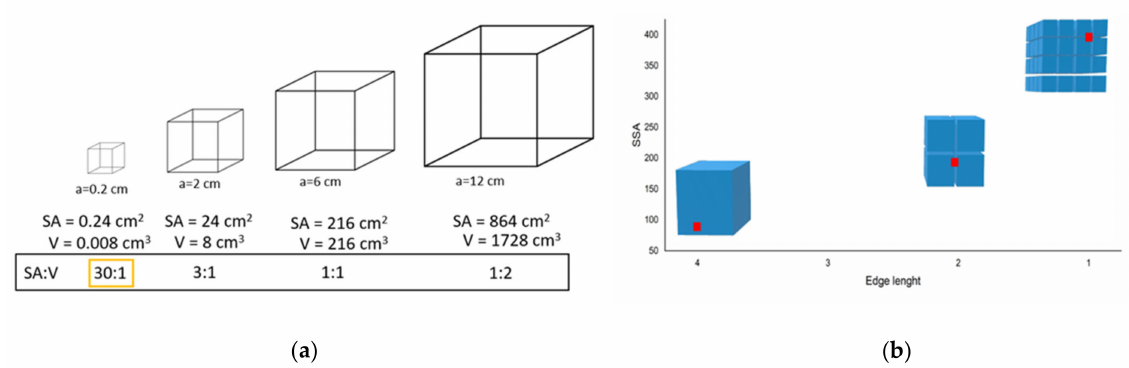
Figure 2. ( a ) Size dependence of the surface-to-volume ratio for hypothetical cubic samples. The SA:V (surface area-to-volume) ratio is represented in the rectangle to show how this ratio increases when particle size is decreased; ( b ) the model of the evolution of specific surface area as compared to the edge length. Red squares represent the data obtained from Baglioni et al. [34] and blue cubes represent the model of the particles at constant